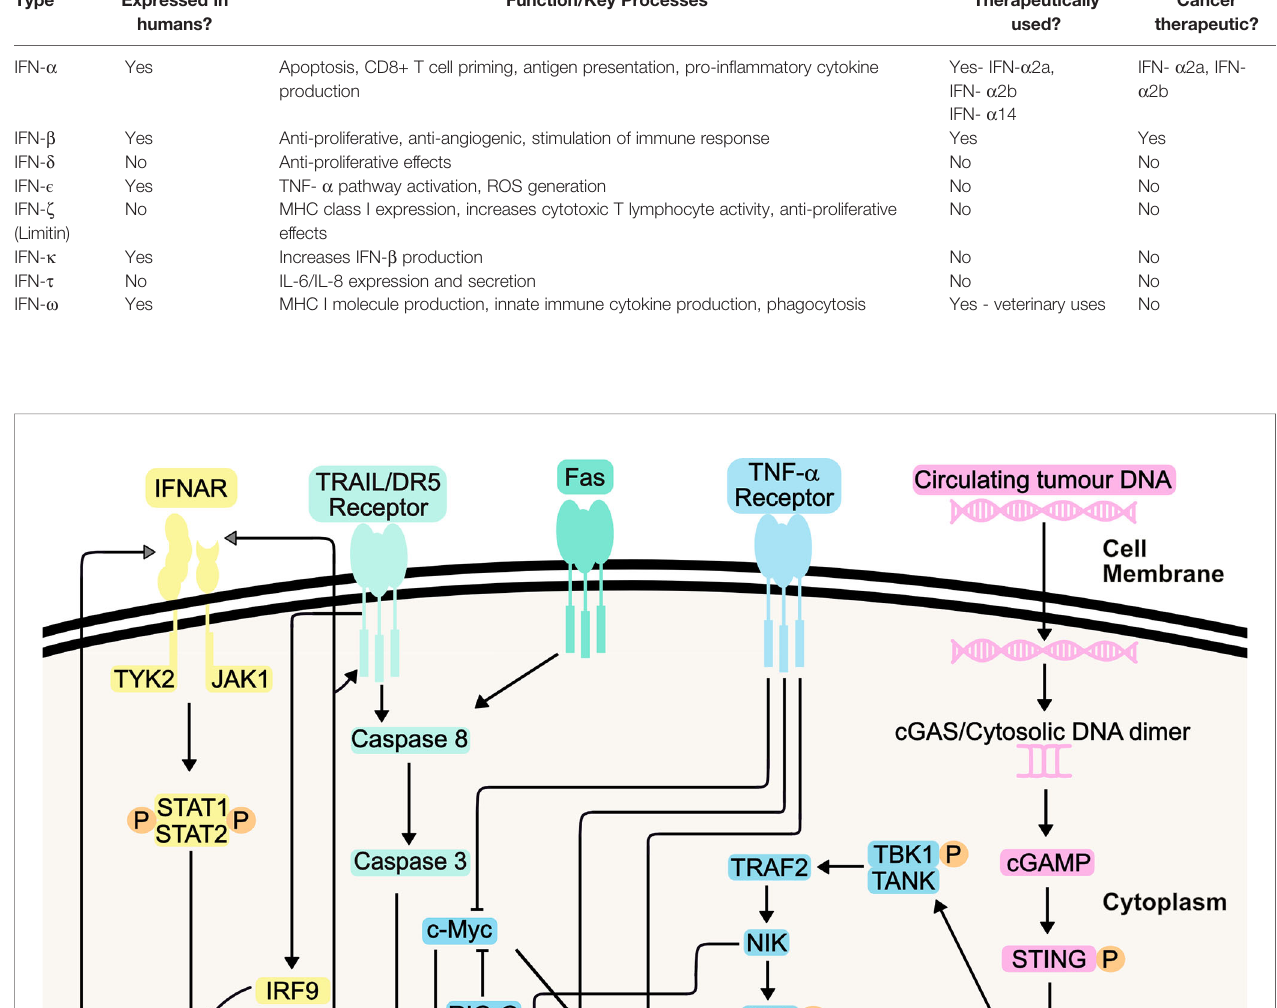
Function/Key Processes Therapeutically